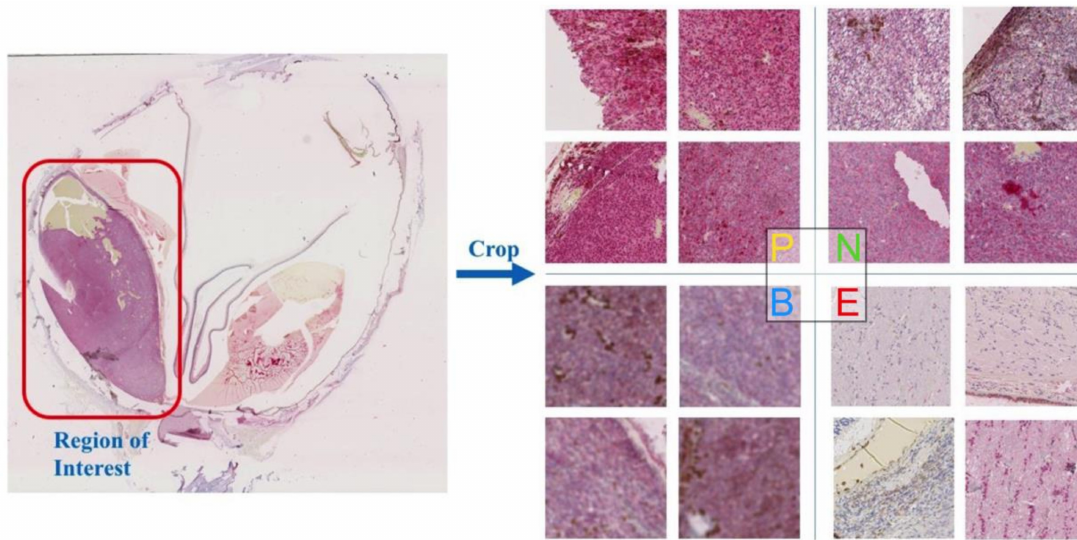
Figure 1. One sample from the dataset of the original scanning of the BAP1 stained uveal melanoma slides and the image patches (256 × 256) cropped from the regions of interest in this image. All patches were divided into four categories: P-positive, N-negative, B-blurred, and E-excluded. We randomly sampled four patches in each category for